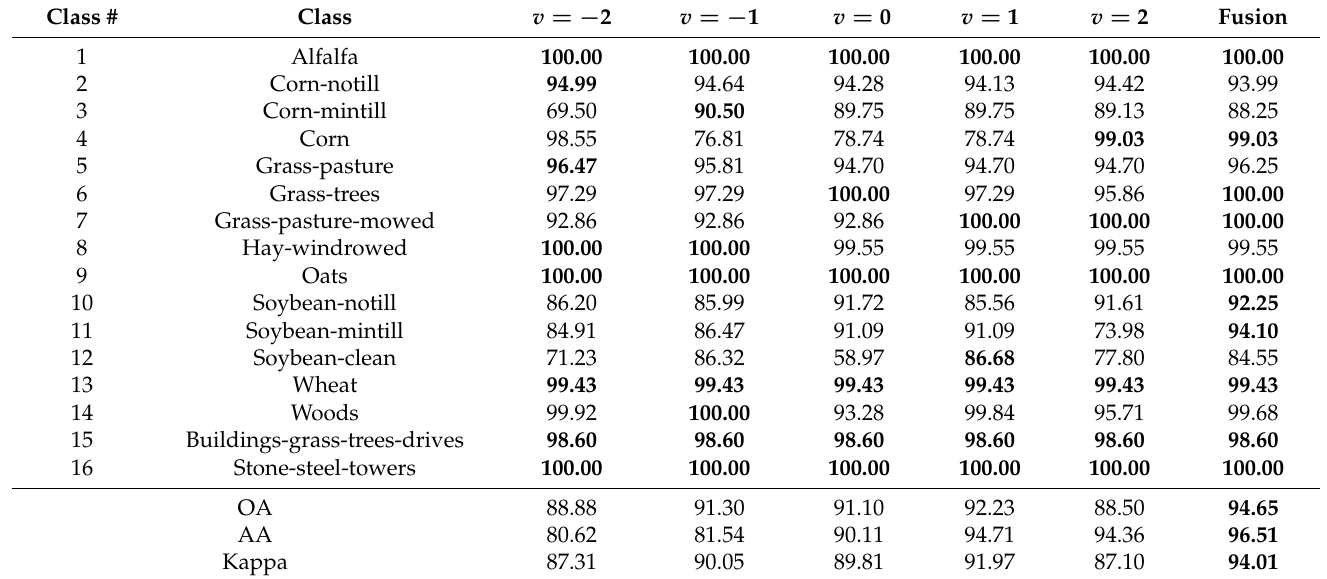
Table 5. Classification performance for different superpixels on the Indian Pines dataset.